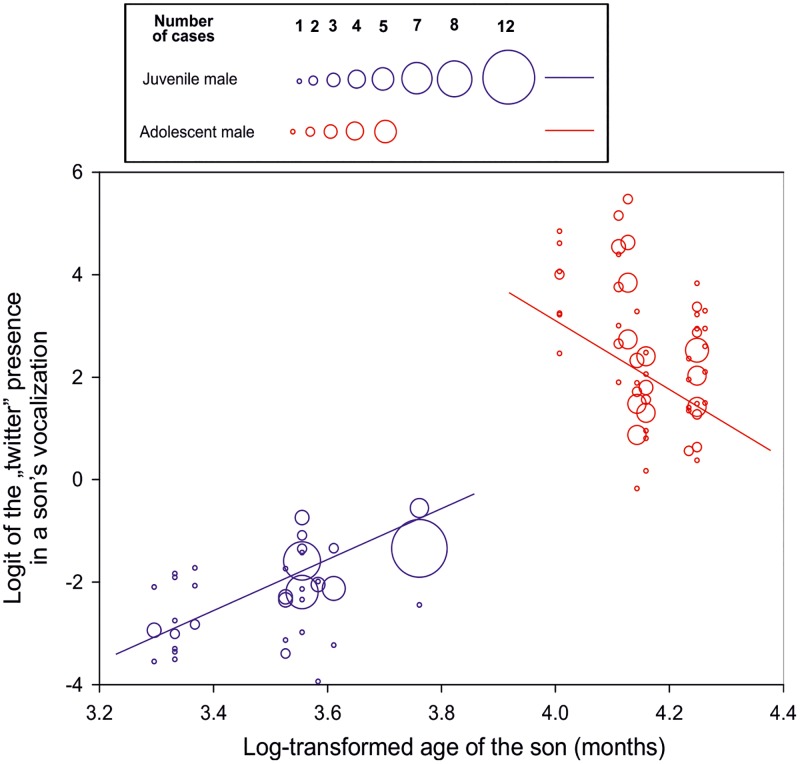
Logit of a “twitter” occurrence in the “great call” of the son plotted against log-transformed age of the juvenile or adolescent son.